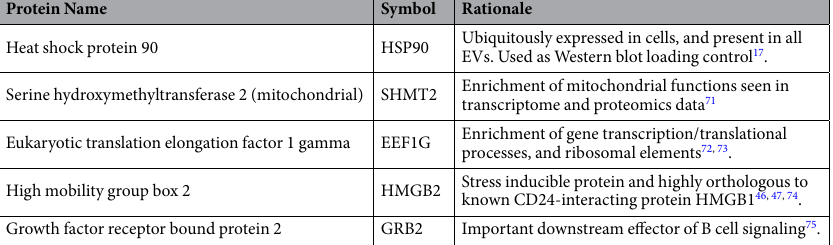
Table 1. Selected proteins from mass spectrometry data for validation by Western blot.